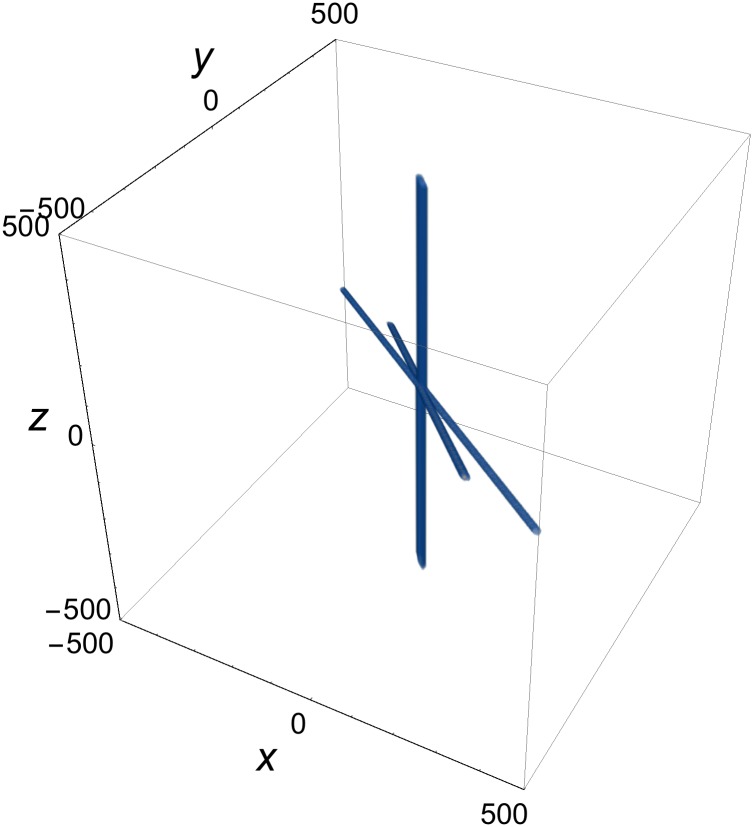
Three intersecting rod solution of Eq (3).p(1) = {0, cosφ(1), sinφ(1), 0}, p(2) = {0, cosφ(2), sinφ2, 0}, p(3) = {1, cosφ(3), sinφ(3),1}; φ(1) = π/5, φ(2) = π/4, φ(3) = π/3; δ(1) = δ(2) = δ(3) = 0.